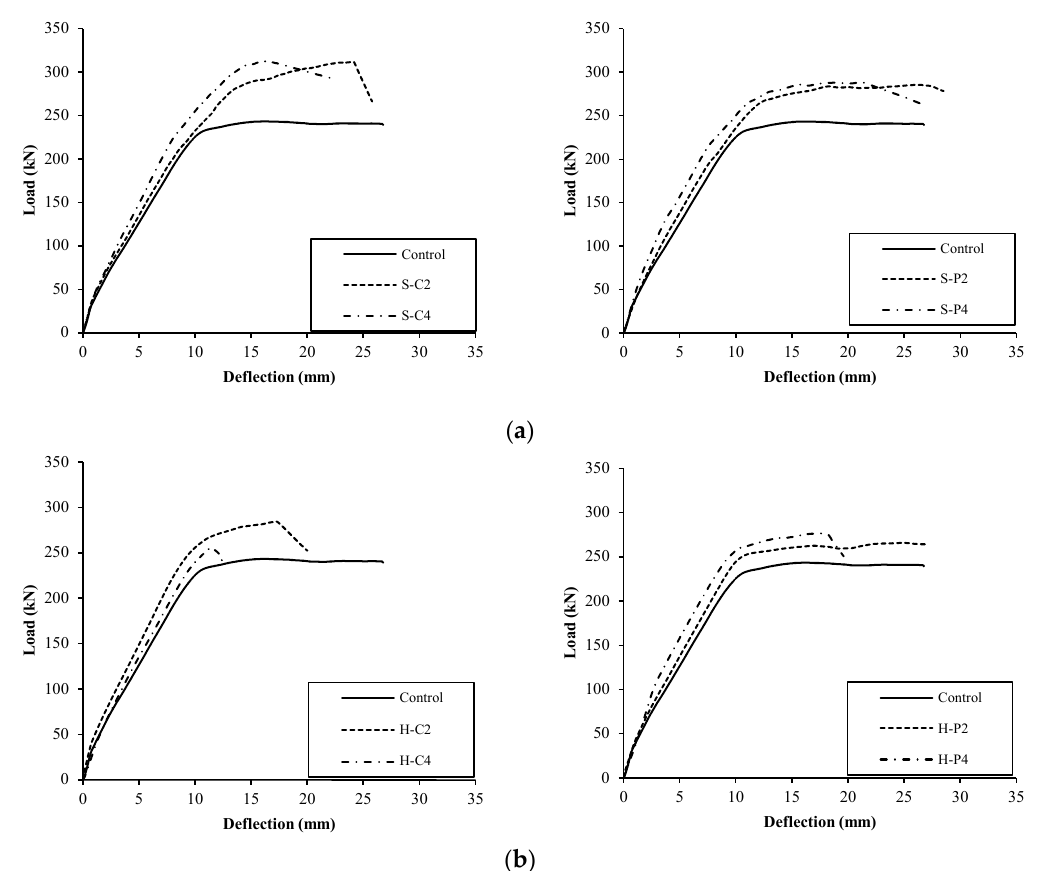
Figure 11. Experimental load-deflection response: ( a ) Group A (sagging strengthening); ( b ) Group B (hogging strengthening).